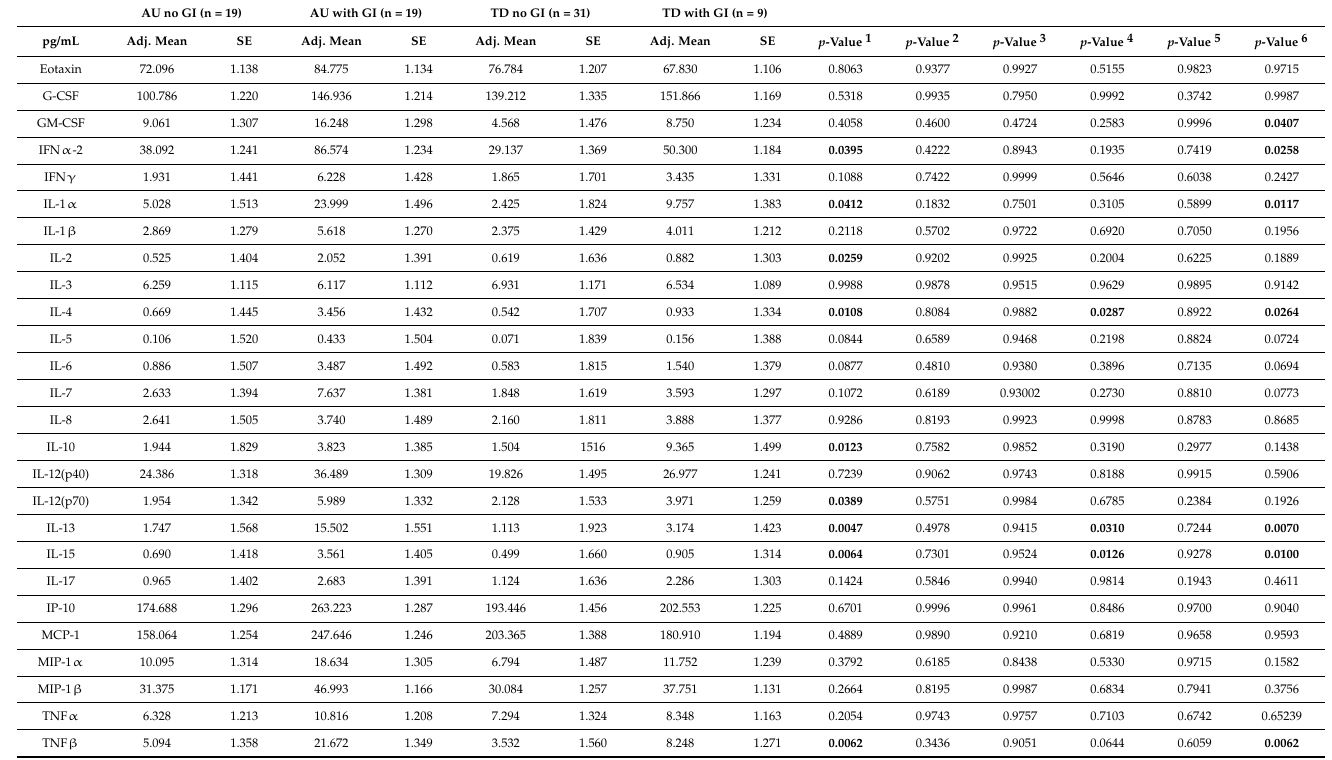
Table 1. Comparison of mean log-transformed cytokine and chemokine concentrations (pg/mL) in AU and TD groups with and without GI symptoms